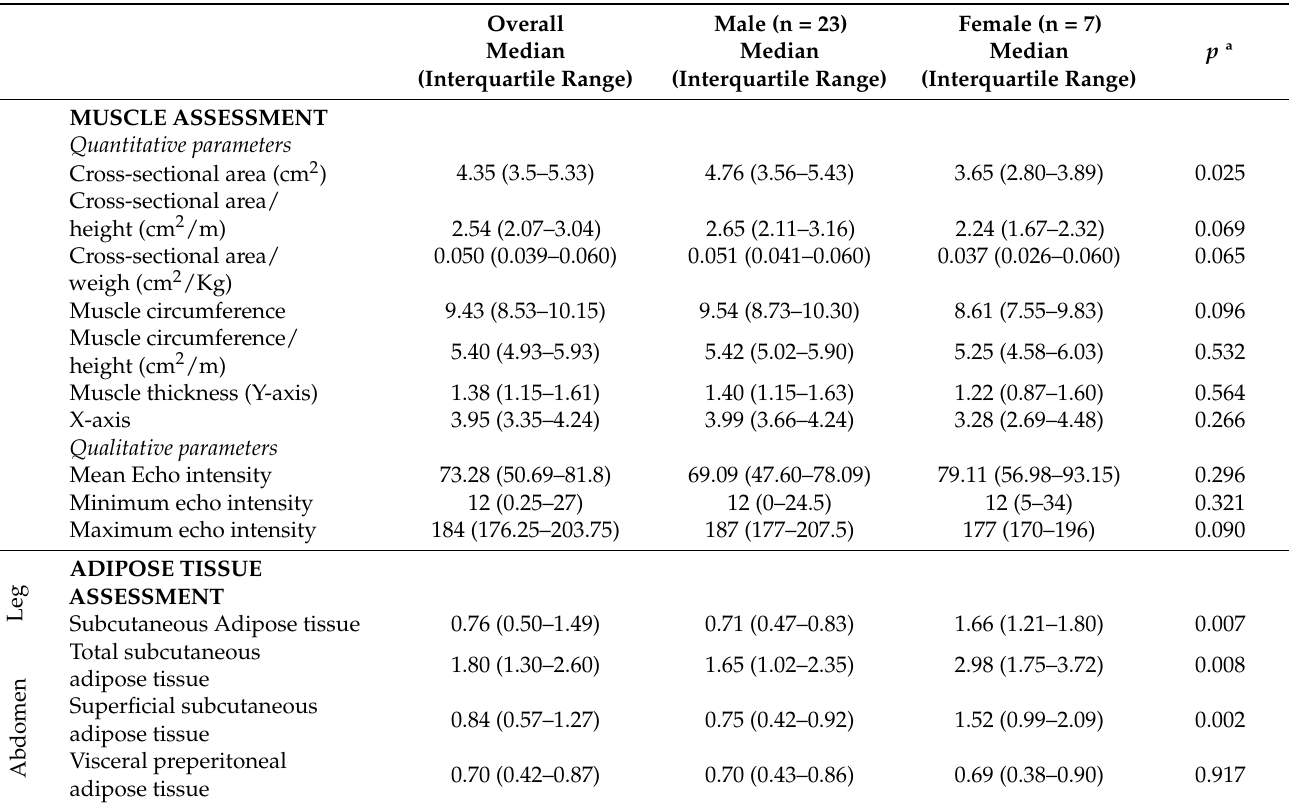
Table 3. Ultrasound evaluation of rectus femoris (RF) muscle and adipose tissue in post-critical COVID-19 patients. Overall Median (Interquartile